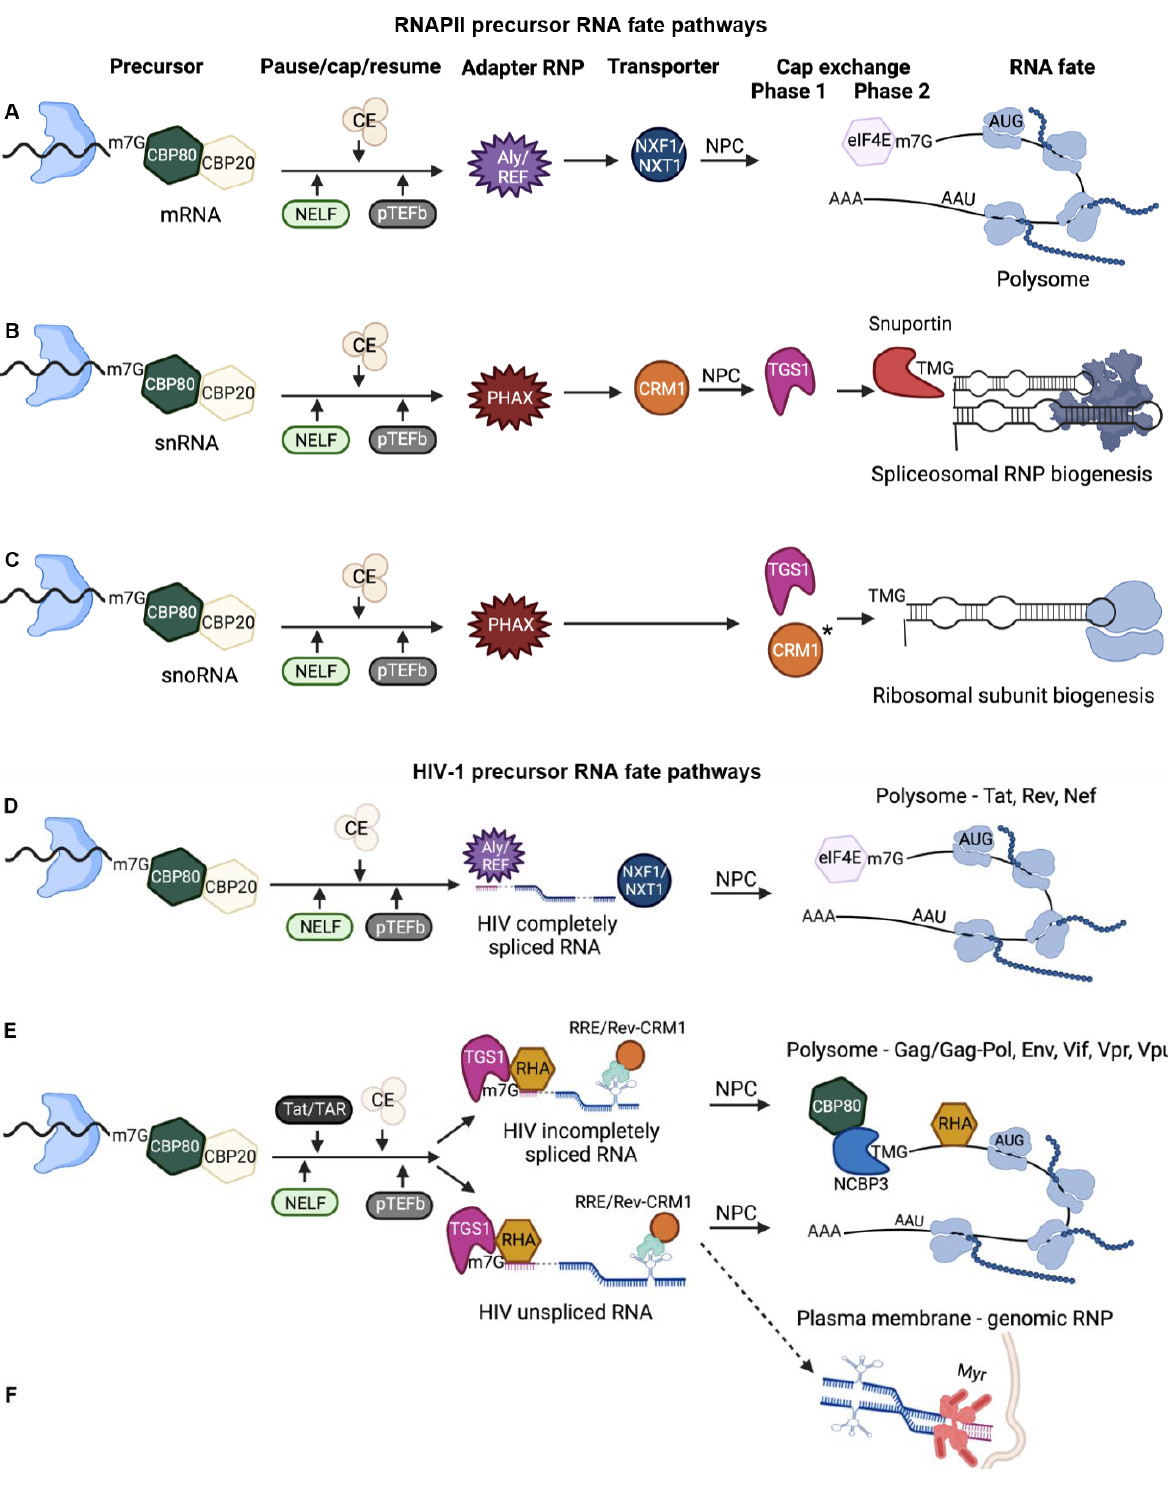
Figure 2. Precursor RNA fate is determined through the co-transcriptional recruitment of RNA binding proteins and subsequent rearrangement of RNP (ribonucleoprotein) components. Nascent RNA shown with paused RNA polymerase II, Blue. CE, capping enzyme. * CRM1 chaperone